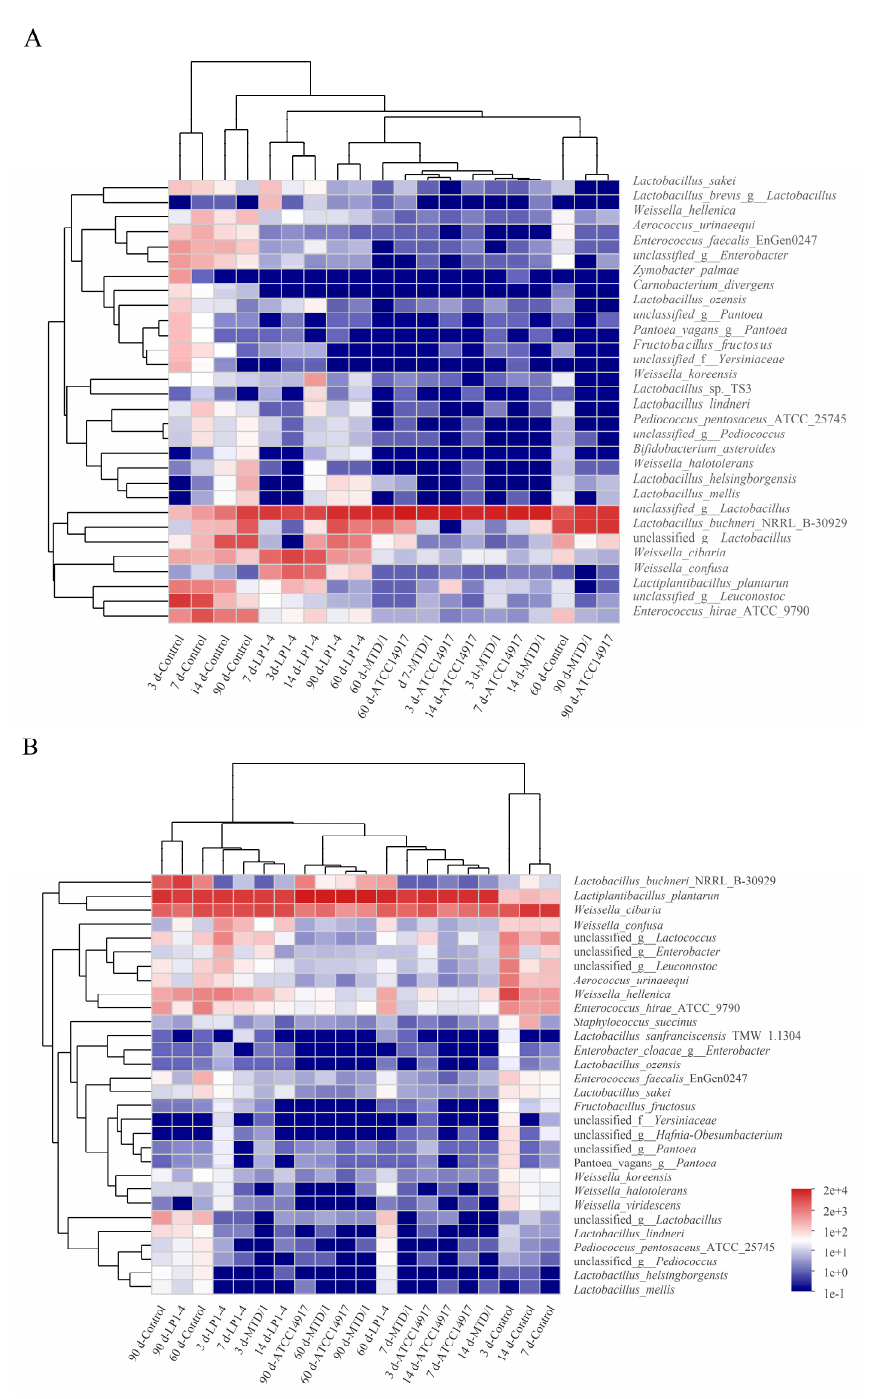
Figure 3. Dynamics of community composition heatmap of silage alfalfa at the ( A ) moderate and ( B ) high dry matter contents, respectively. Control, distilled water; MTD/1, MTD/1 treatment; ATCC14917, ATCC14917 treatment.